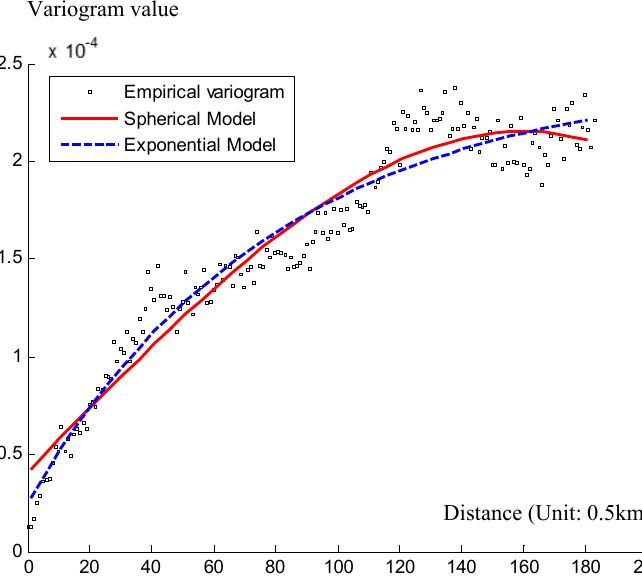
Figure 8. Fitting results of different variograms of WEEE return for J company.